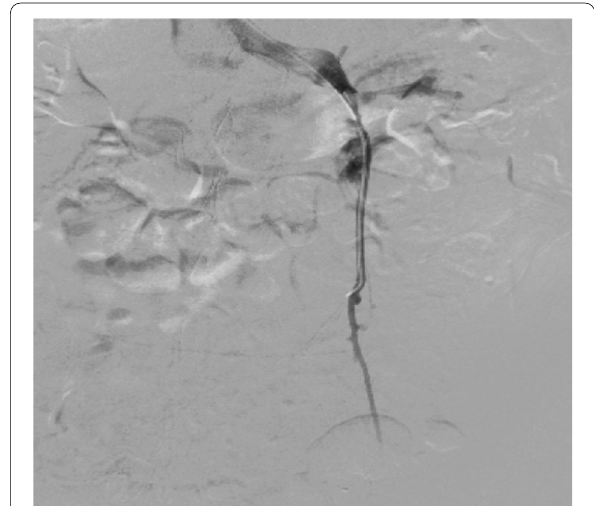
Fig. 6 Post sclerotherapy image showing left ISV stump with no collaterals or reflux (angiographic